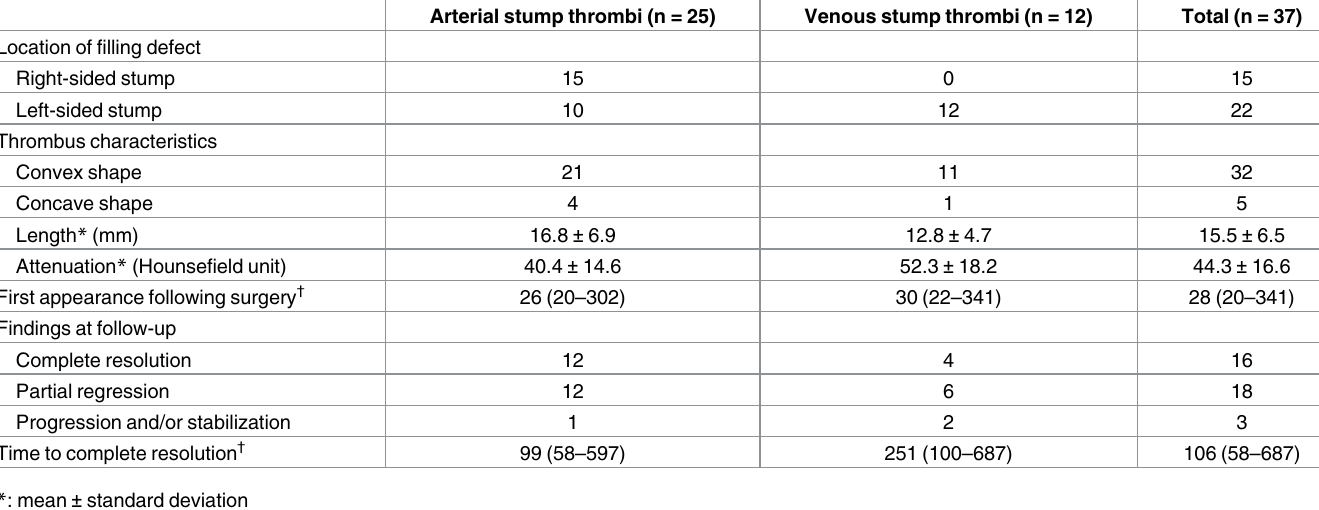
Table 2. Radiologic features of stump thrombi.